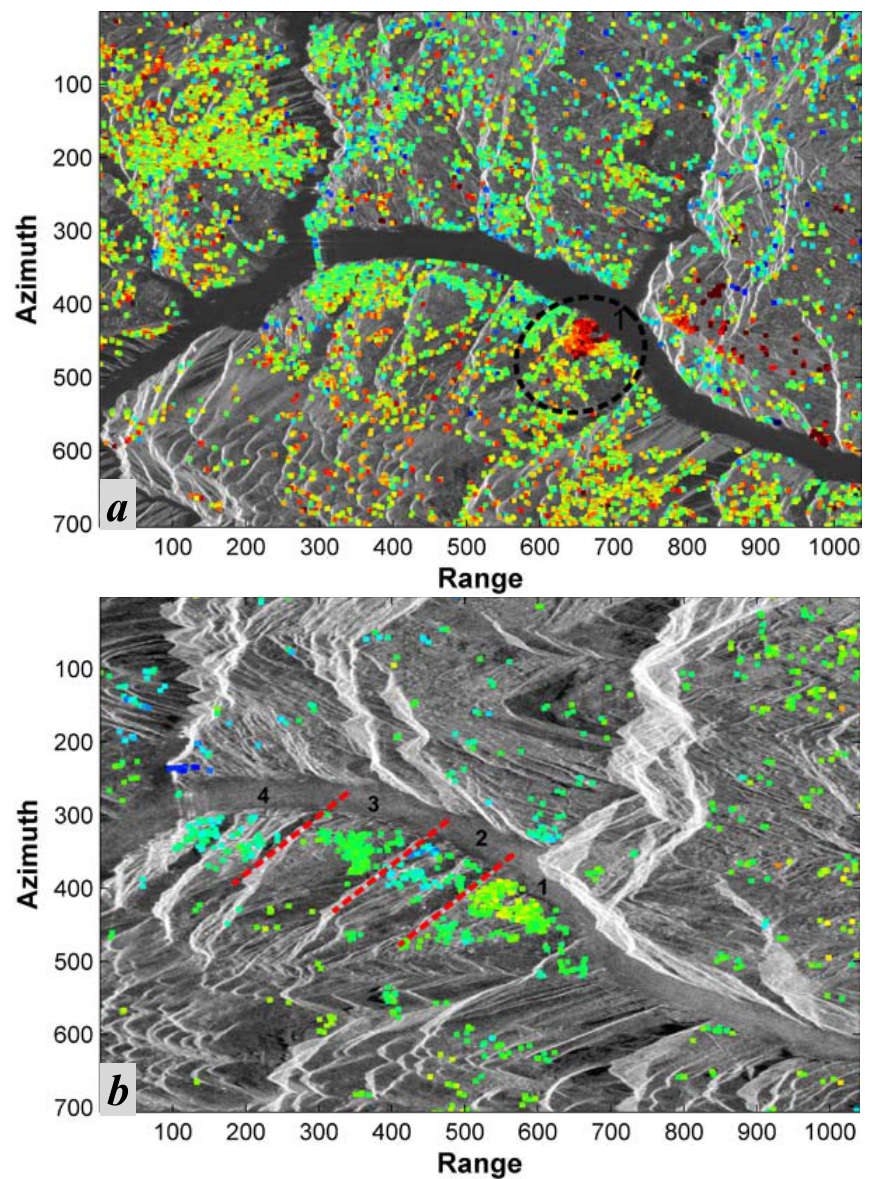
Figure 4. Deformation velocities at PS points in Badong identified by PS-InSAR: ( a ) from Advanced Land Observing Satellite (ALOS) Phased Array L-band Synthetic Aperture Radar (PALSAR) data; ( b ) from Environmental Satellite (ENVISAT) Advanced Synthetic Aperture Radar (ASAR) ascending data; and ( c ) from ENVISAT ASAR descending data. The numbered circles outline the two active landslides. The number 1 in (a) refers to the Huangtupo landslide. The red lines in (b) divided the southern riverbank into several significant deformation zones. The red star in (c) indicates the location of the reference